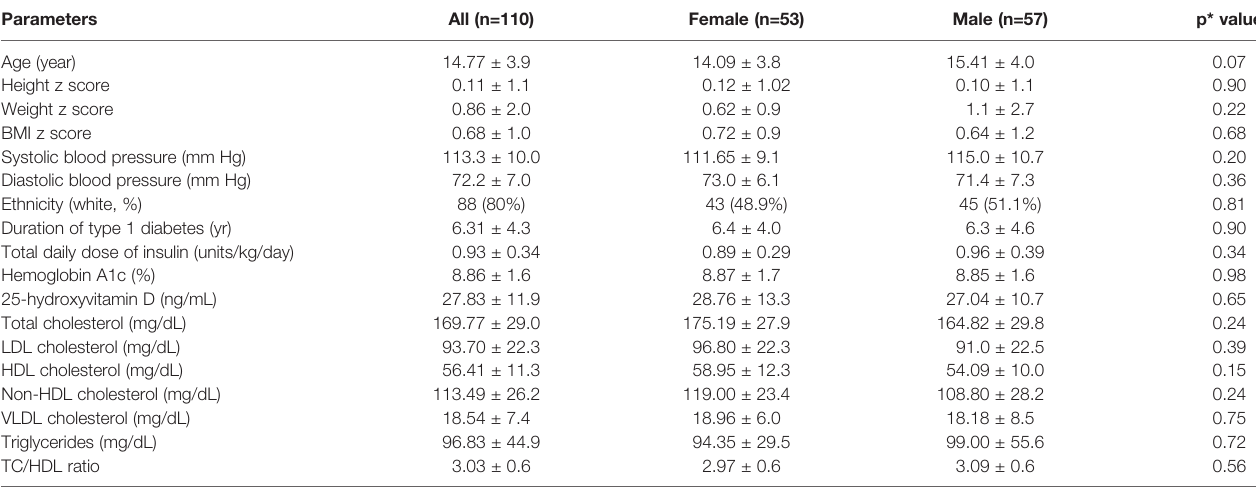
TABLE 1 | Baseline characteristics of the subjects.